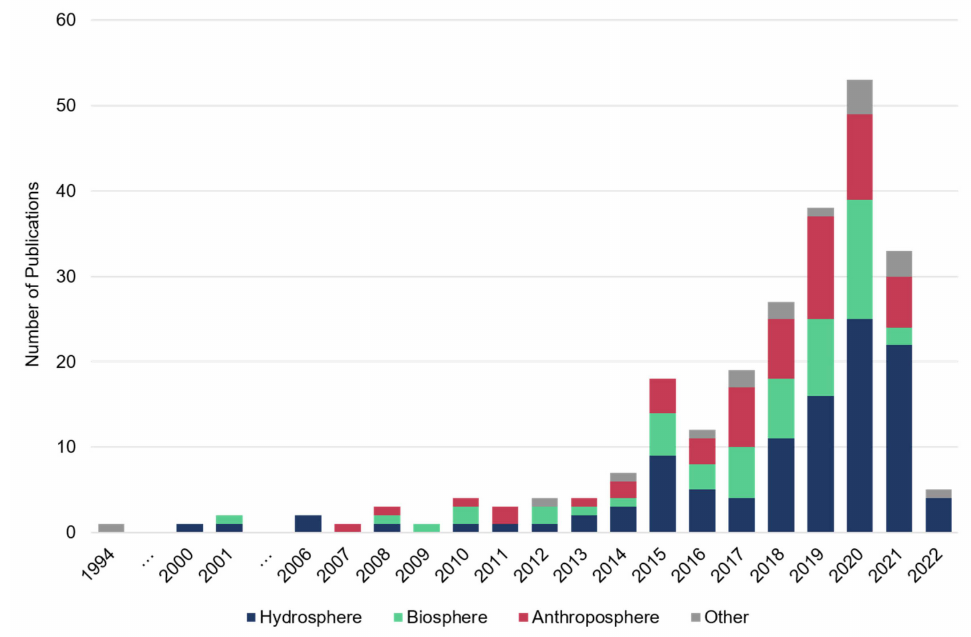
Figure 3. Increasing number of publications with indication of thematic focus (situation in March 2022). No publications fit our scope for the years 1995–1999 and 2002–2005, resulting in data